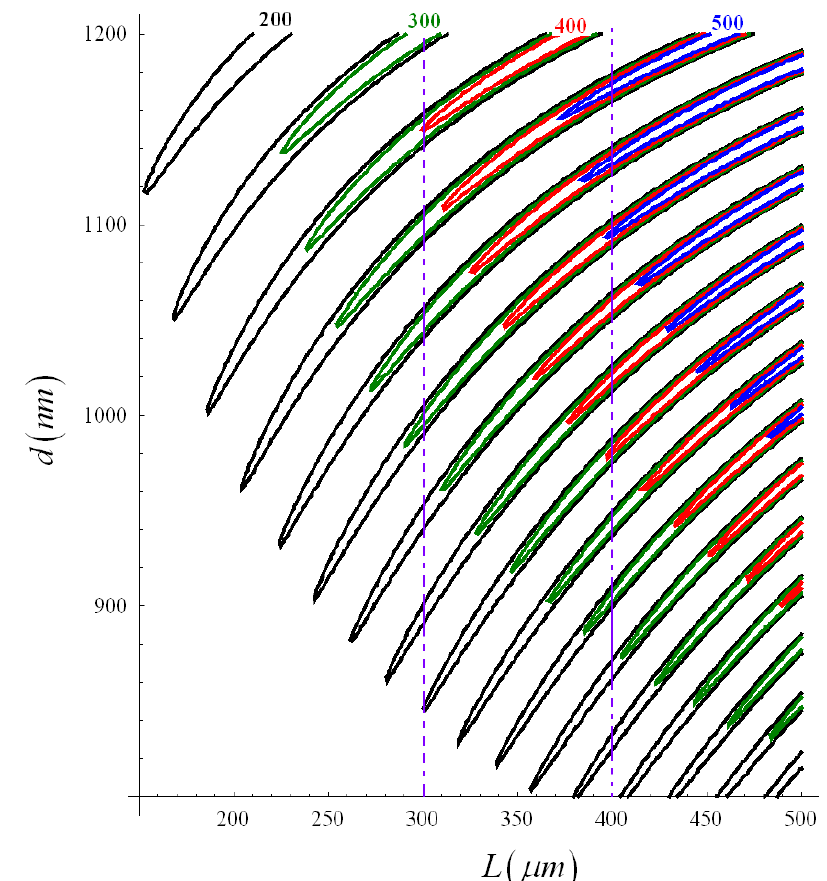
S as a function of L and d (quasi-TE mode, Ψ 2 = 1 P